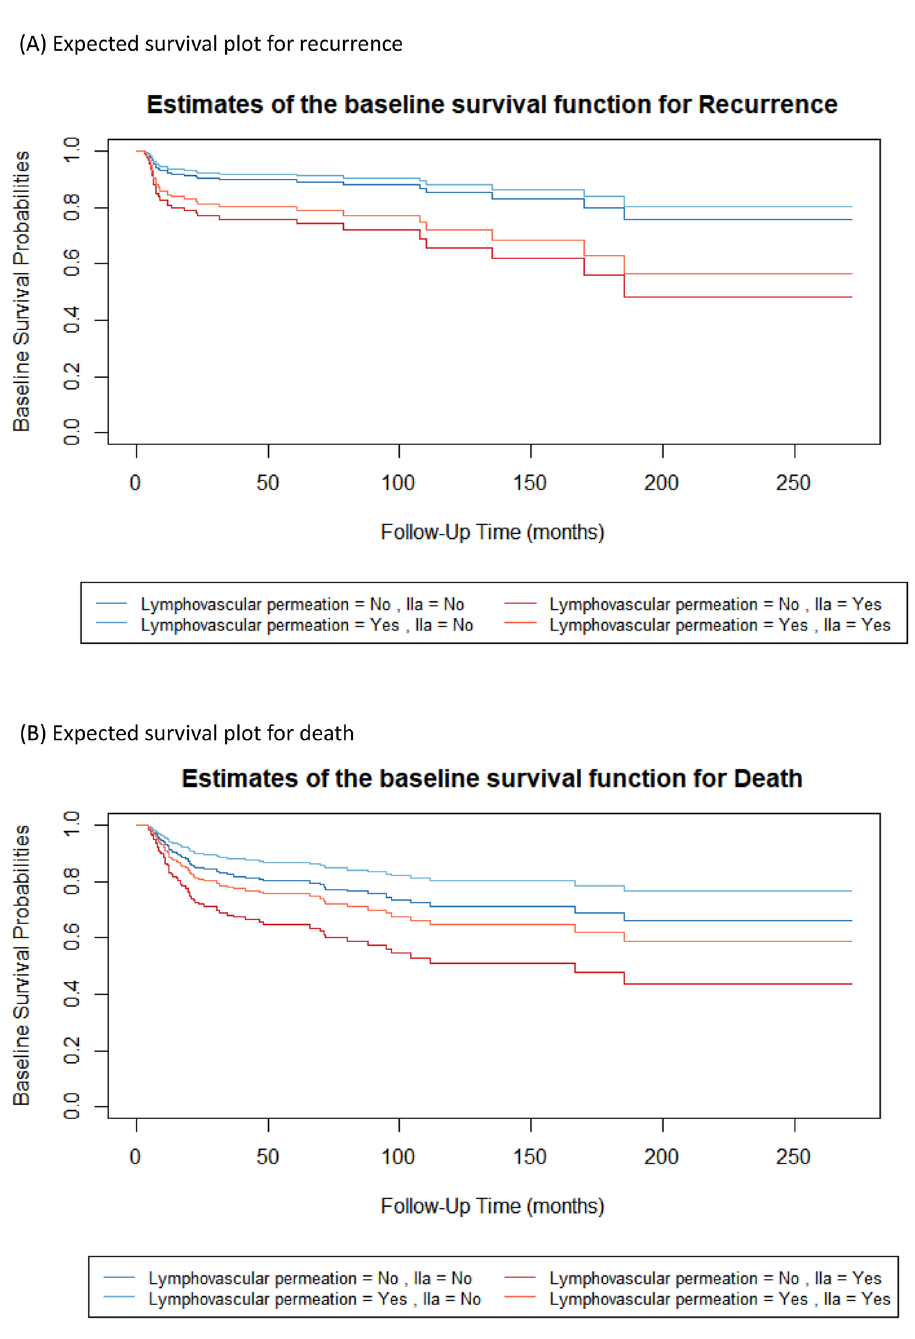
Figure 3. Survival analysis of OSCC(oral squamous cell carcinoma) patients of present study grouped into four categories : LVP positive/Level IIa negative, LVP negative/Level IIa negative, LVP negative/Level IIa positive, and LVP positive/Level IIa positive. (A) Expected survival probability plot for recurrence, (B) expected survival plot for